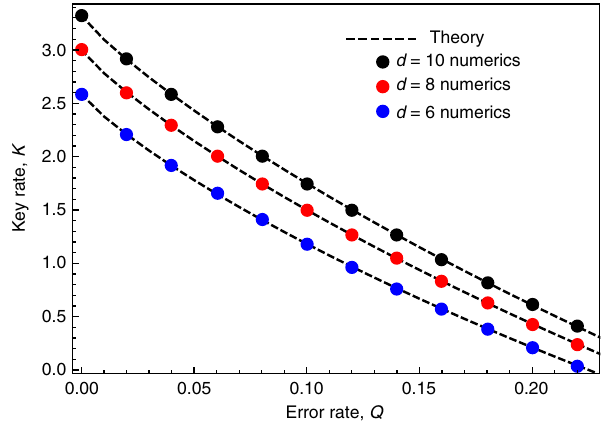
Figure 3 | Higher dimensional analog of BB84, using two MUBs. This plot shows the theoretical key rate as solid curves, and the result of our numerical optimization as circular dots, for d A ¼ d B ¼ d , with d ¼ 6 (blue), d ¼ 8 (red), and d ¼ 10 (black). Again, the dots should be viewed as reliable lower bounds, but in this case they are perfectly